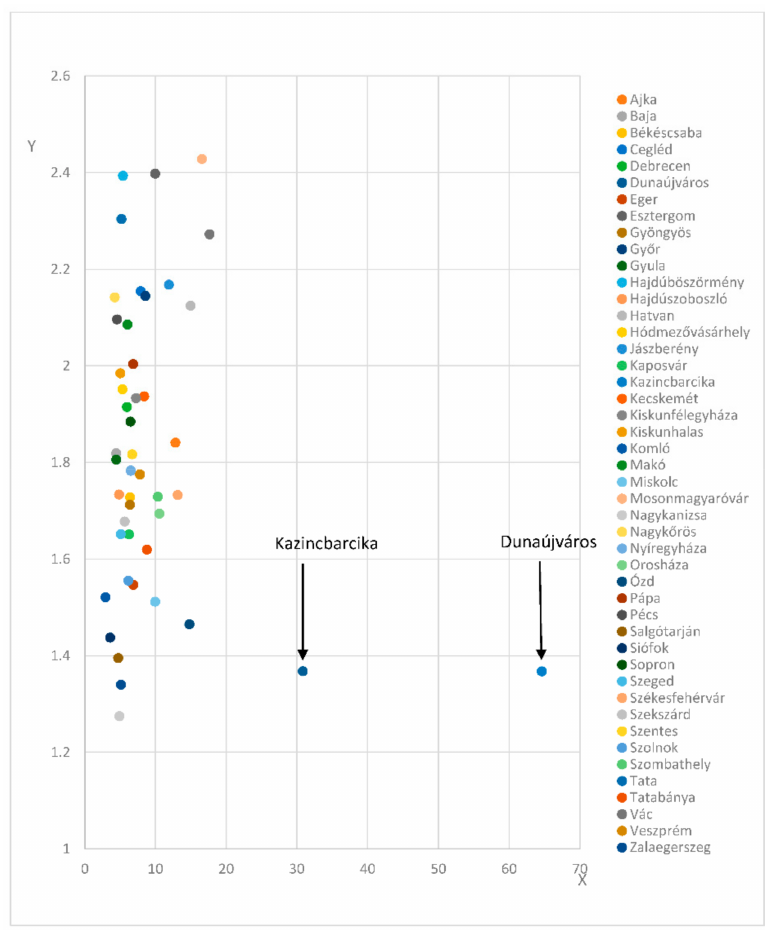
Figure 7. The entire amount of electrical power used in the settlement and by households. Legend: Axle Y = The amount of electricity provided to households (1000 kWh/household); Axle X = The total amount of electricity provided (1000 kWh/total consumers) ( n =